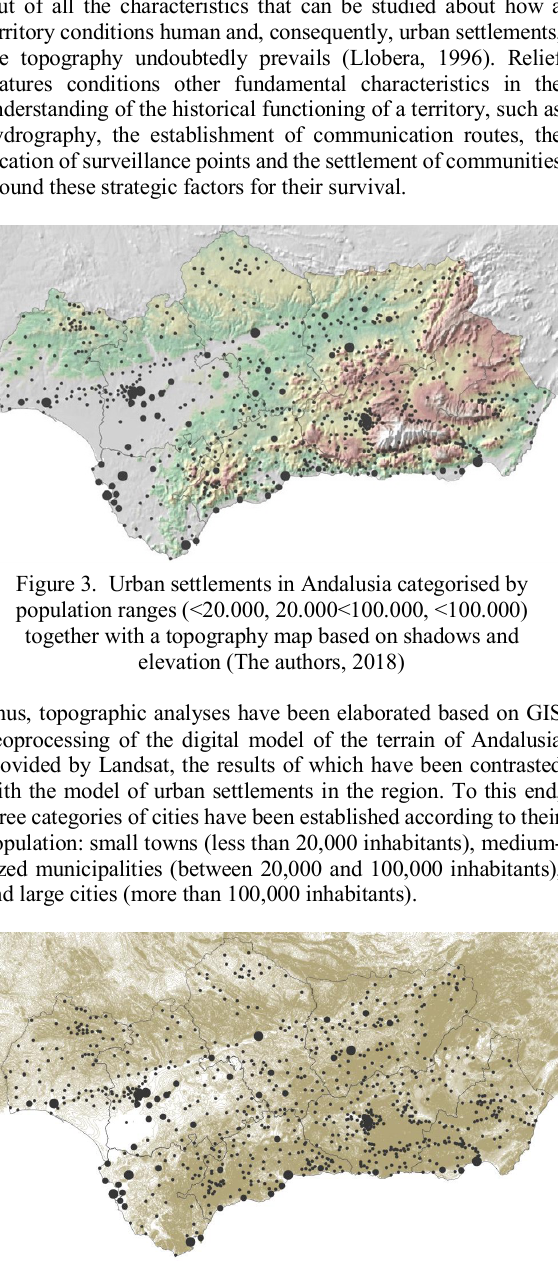
Figure 4. Urban settlements in Andalusia categorised by population ranges (<20.000, 20.000<100.000, <100.000) together with a topography map based on contour